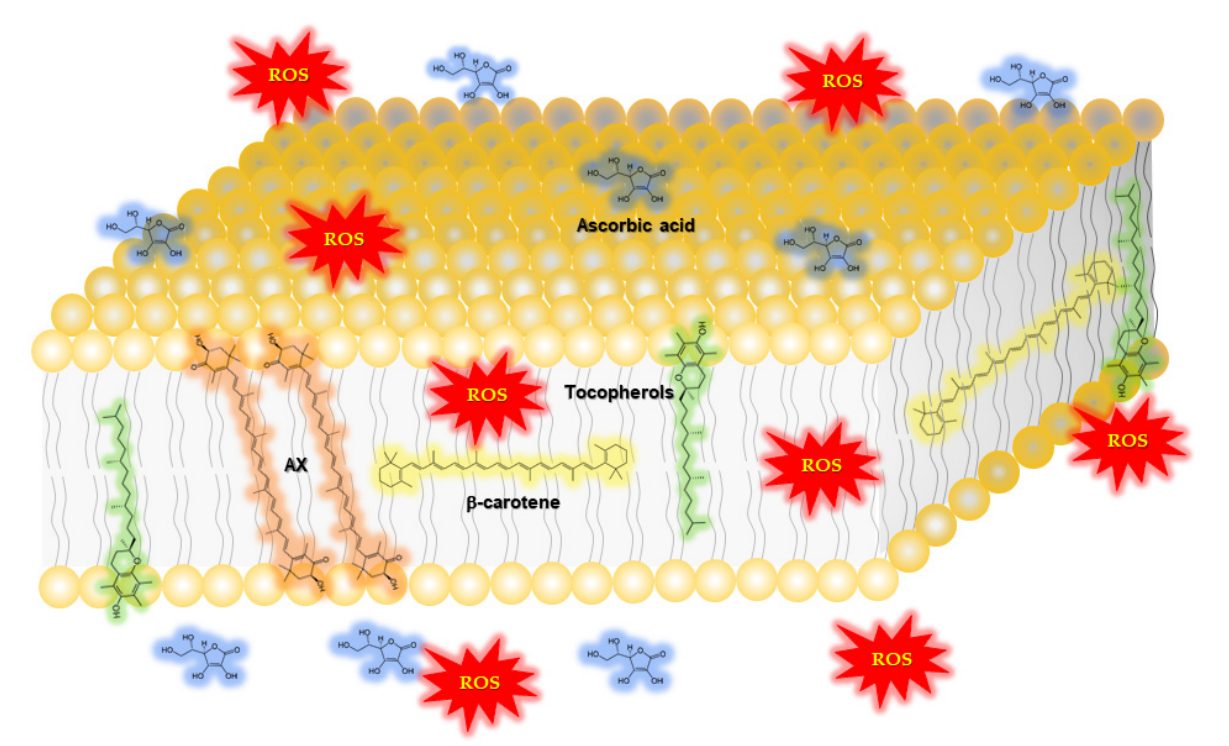
Figure 2. AX performs its antioxidant activity both inside and on the surface of the plasma membrane. Due to its strongly hydrophobic conjugated polyene structure and terminal polar groups, AX can exist both inside and on the surface of the phospholipid membrane. Therefore, AX is able to exert its effects against ROS both at the surface and inside of phospholipid membranes. On the other hand, β -carotene exerts its antioxidant activity only inside the phospholipid membrane. As for other antioxidants, ascorbic acid cannot exert its effect inside the phospholipid membrane, due to its high hydrophilicity, whereas tocopherols are relatively effective at the surface of the phospholipid membrane. This figure excludes the detailed structure of the cell membrane, including localization of different levels of lipids lipid rafts and proteins to avoid complications.